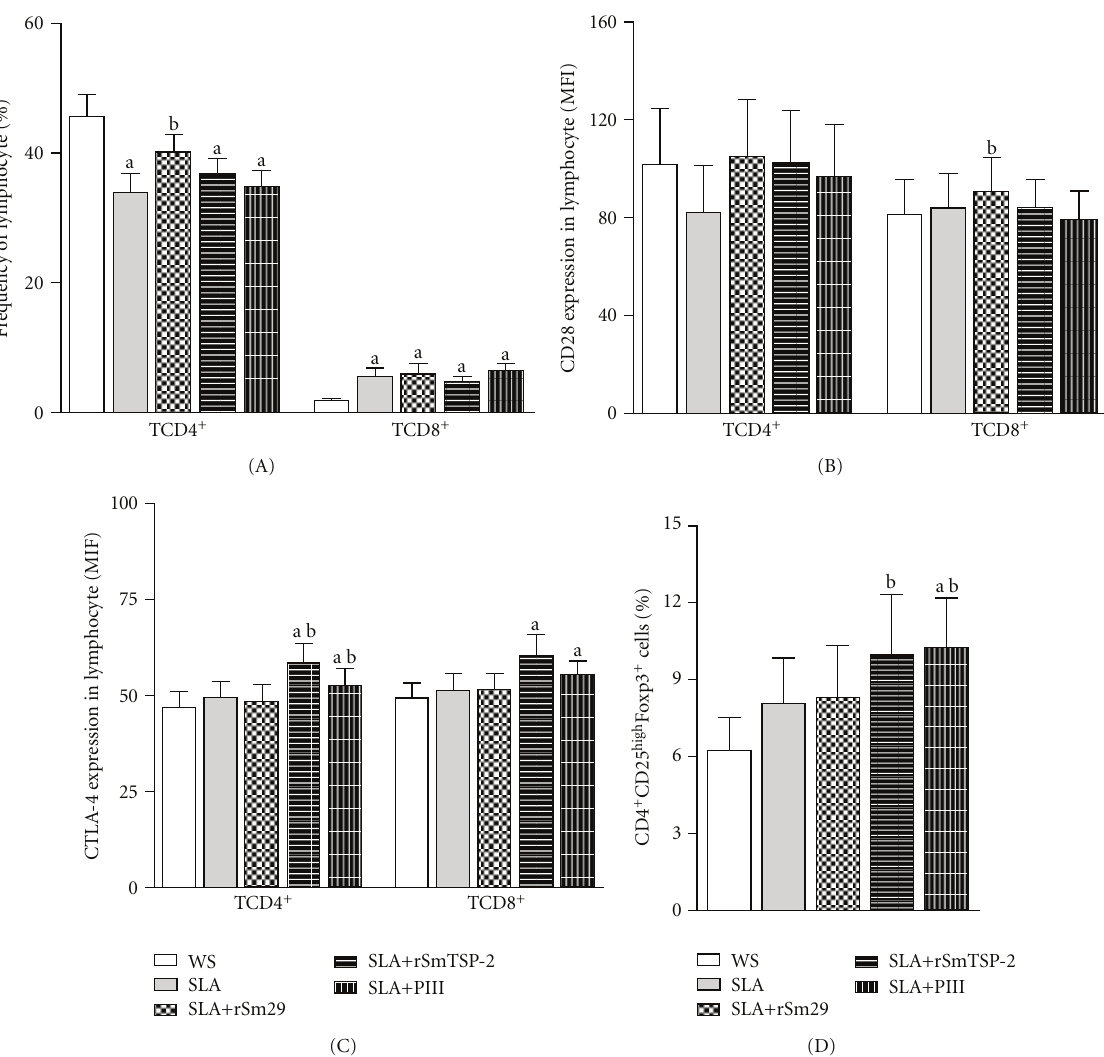
Figure 3: Phenotype of T cells and co-stimulatory molecules expression on T lymphocytes of CL patients ( n = 17) stimulated in vitro with SLA in the presence or absence of S. mansoni antigens rSm29, rSmTSP-2 or with a fraction of S. mansoni soluble adult worm antigen (SWAP) PIII. Frequency of CD4 + and CD8 + T cells (A), expression of CD28 and CTLA-4 in CD4 + and CD8 + T cells (B and C, resp.) and the frequency of CD4 + CD25 high Foxp3 + T cells ( n = 13) (D). Cells were stained for surface expression of CD4, CD8, CD25 and CD28, while the expression of CTLA-4 and Foxp3 were evaluated intracellularly using flow cytometry. a P < 0 . 05 cultures without stimulation (WS) versus SLA + S. mansoni antigens; b P < 0 . 05 SLA versus SLA + S. mansoni antigens (Wilcoxon matched pairs